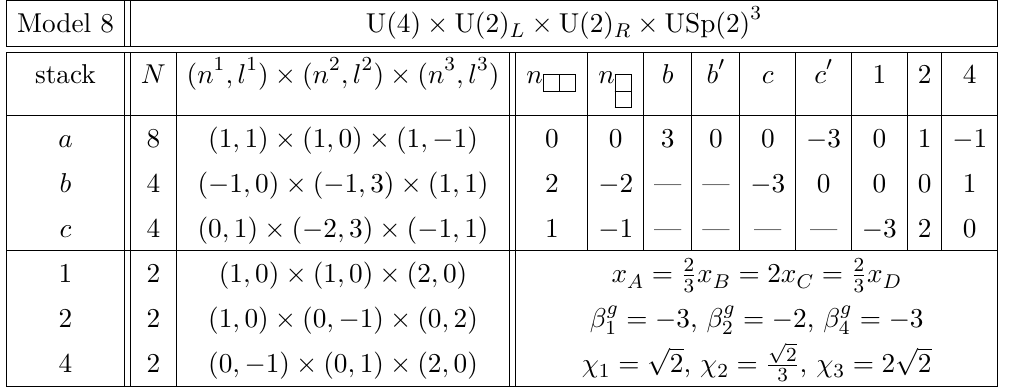
Table 15 . D6-brane configurations and intersection numbers of Model 8, and its MSSM gauge